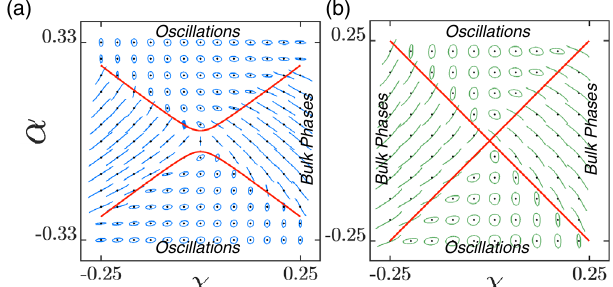
FIG. 5. Pattern formation in the plane of reciprocal and nonreciprocal interactions. A stability analysis is shown in the ð χ ; α Þ plane for c 1 ; 1 ¼ − c 1 ; 2 ¼ c 1 and c 2 ; 1 ¼ − c 2 ; 2 ¼ c 2 , for (a) the general case c 1 ≠ c 2 and (b) the special case c 1 ¼ c 2 . The red lines indicate exceptional points at which the eigenvalues collapse and the corresponding eigenvectors become parallel. The results of the stability analysis are verified using simulations: The parameters scanned are shown using black dots, and at each dot, the steady-state limit cycle is plotted to show whether the system goes into oscillations or bulk phase separation. The stiffness parameter κ ¼ 0 . 05 . The system size of 201 × 201 is used in all of the simulations here, with a time step of 10 − 2